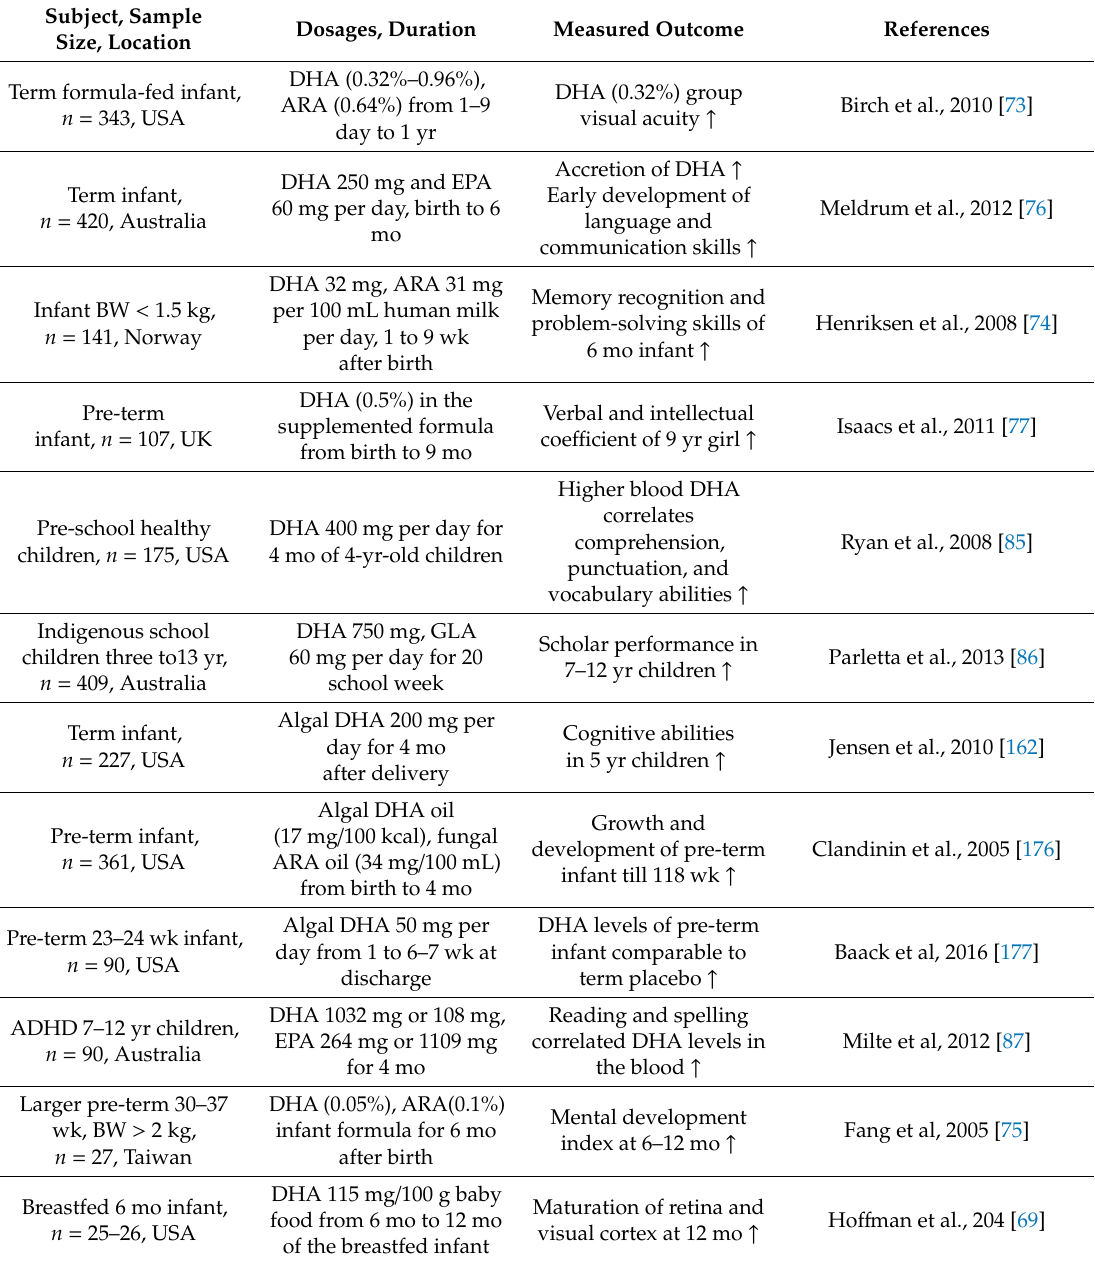
Table 2. Supplementation of DHA on the neonatal visual, verbal, and cognitive development: a collection of Randomized Controlled Trials